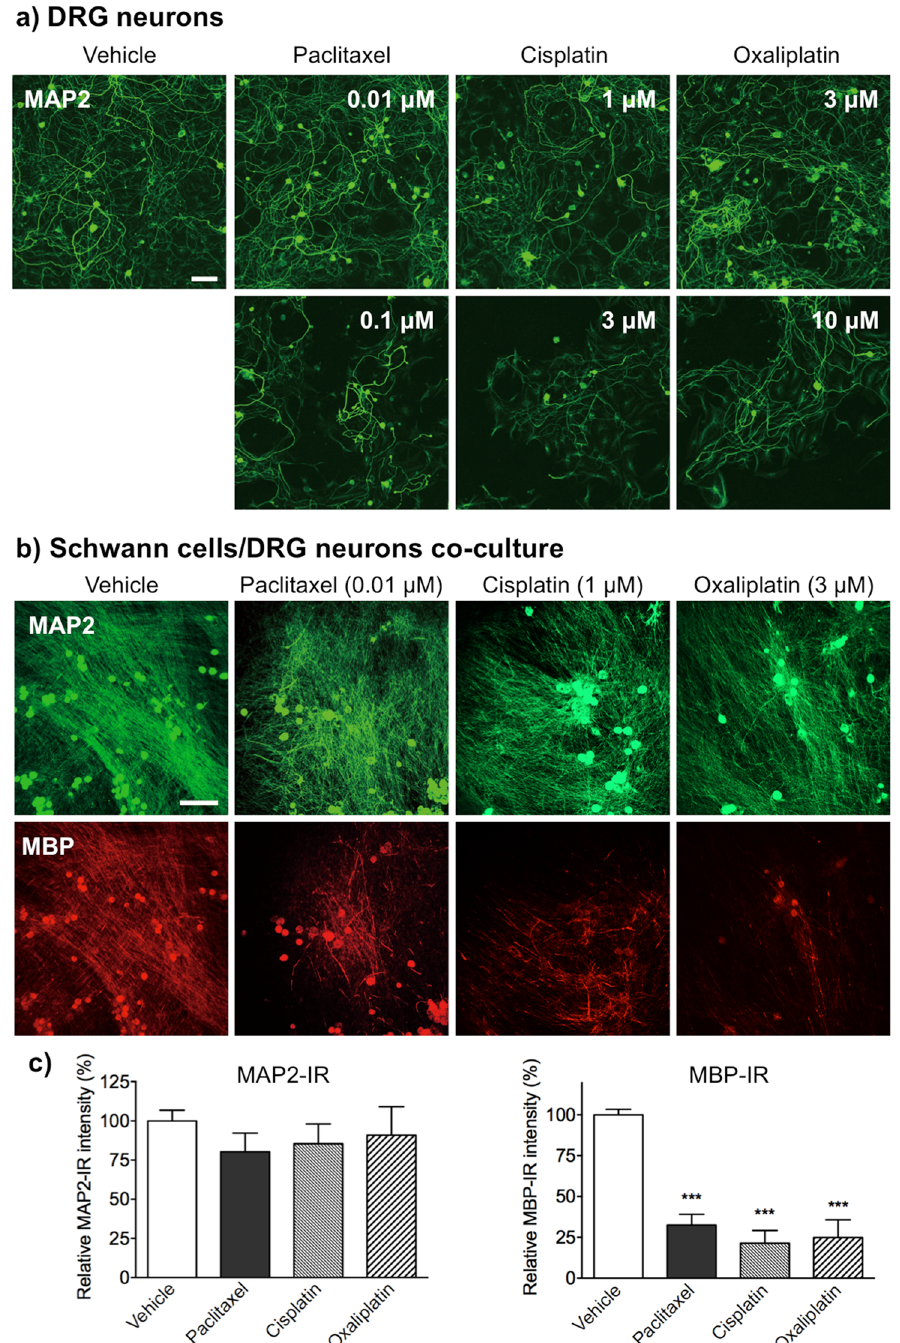
Figure 4. Effects of paclitaxel, cisplatin and oxaliplatin on primary cultured DRG neurons or on co-cultures of Schwann cells and DRG neurons. ( a ) Immunofluorescence staining of primary cultured DRG neurons for MAP2. Primary cultured DRG neurons were treated with vehicle (0.1% DMSO), paclitaxel (0.01 and 0.1 μ M), cisplatin (1 and 3 μ M) or oxaliplatin (3 and 10 μ M) for 48 h. Only higher doses of paclitaxel (0.1 μ M), cisplatin (3 μ M) and oxaliplatin (10 μ M) reduced the number of DRG neurons and associated dendritic trees, and shortened the neuritic processes. Scale bar: 100 μ m. ( b ) Co-cultures were treated with vehicle (0.1% DMSO), paclitaxel (0.01 μ M), cisplatin (1 μ M), or oxaliplatin (3 μ M) for 48 h. Scale bar: 200 μ m. Each treatment reduced formation of MBP-positive myelin; however, no morphological changes were observed in MAP2-positive DRG neurons. ( c ) MBP- or MAP2-IR in co-cultures. Each column represents the mean ± S.E.M. n = 3. *** p < 0.001 vs . the vehicle-treated